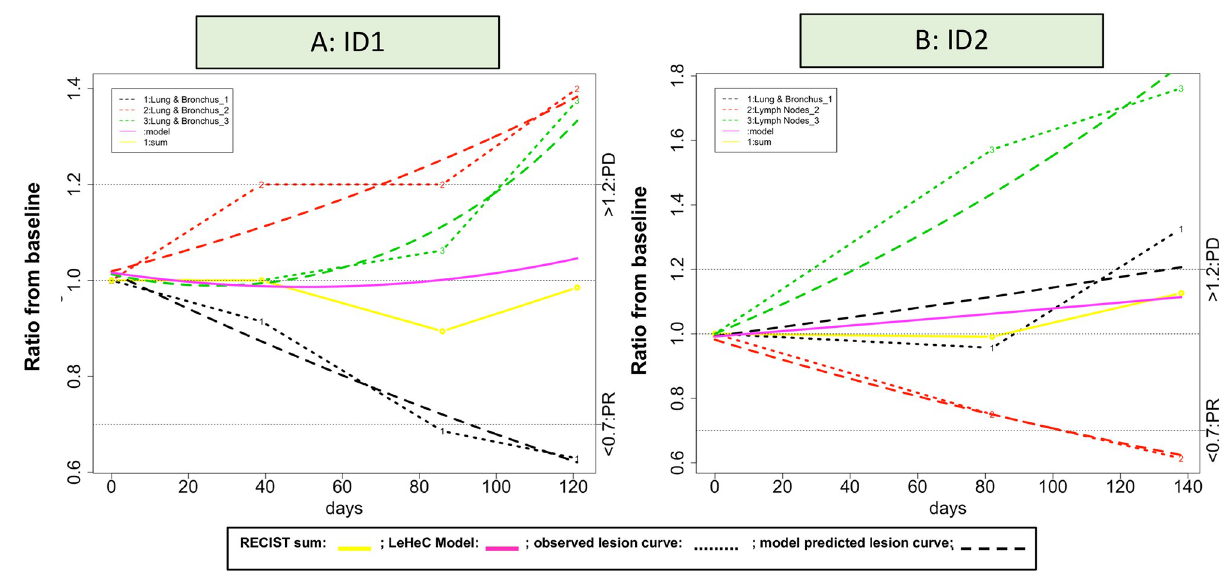
Fig 5. Mixed response.